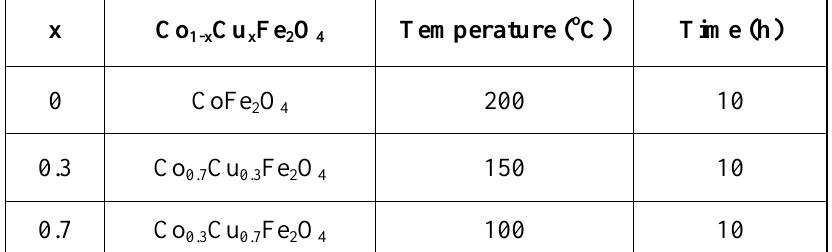
Table 4: Most convenient hydrothermal synthesis conditions of copper substituted cobalt ferrite